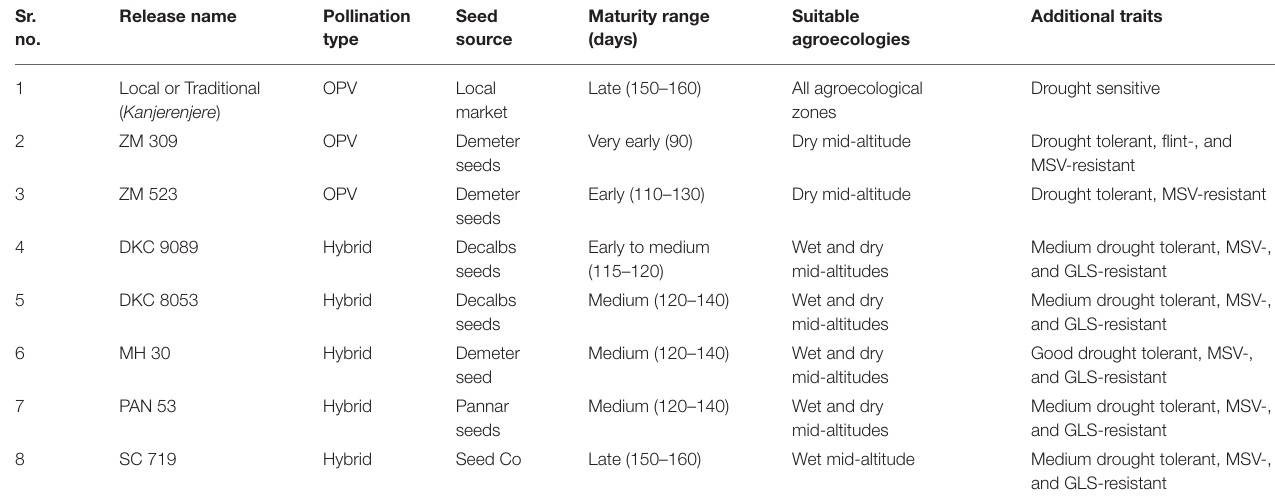
TABLE 1 | Characteristics of the eight maize varieties used in this study. Sr.